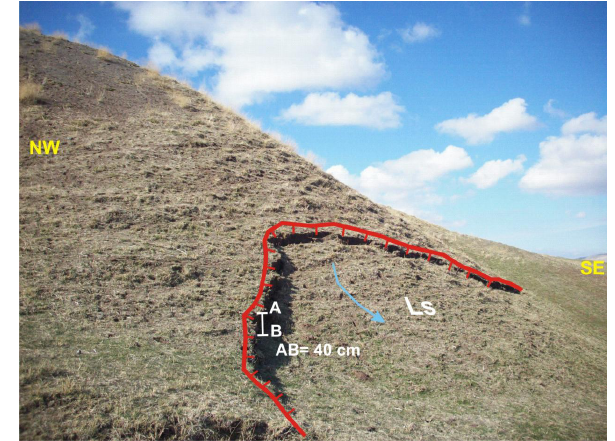
1 2 Figure 6. A view from a confined landslide on a slope located northwest of Kozluca Village. 3 Fig. 6. A view from a confined landslide on a slope located north- west of Kozluca village.